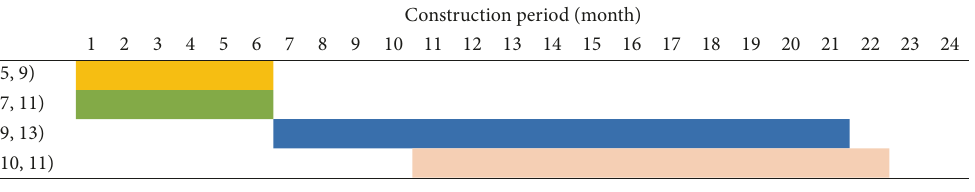
Figure 7: Selection and scheduling results with separate optimization for Scenario 1 .